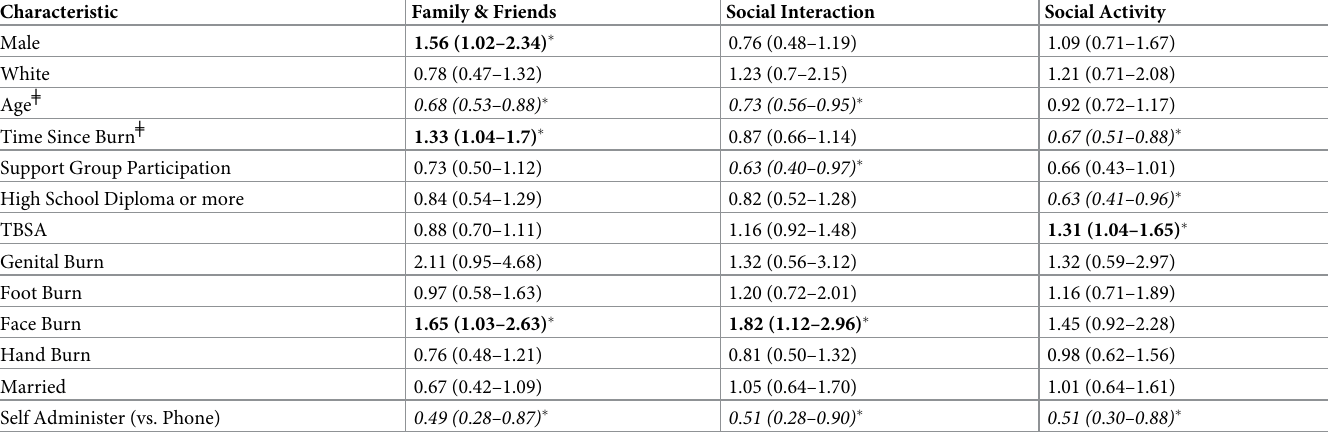
Table 3. Logistic regression model predicting subjects in higher PERS factor score and lower substantive factor score group. (Odds ratio and 95% confidence